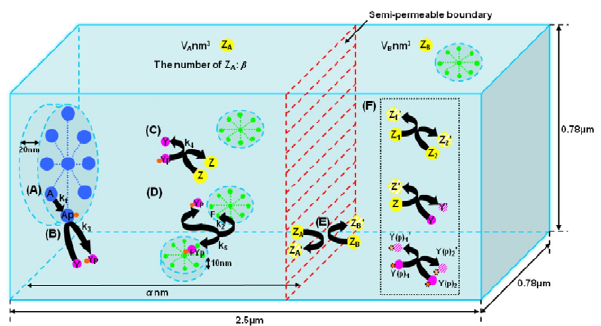
Figure 7. The E.coli simulation system.